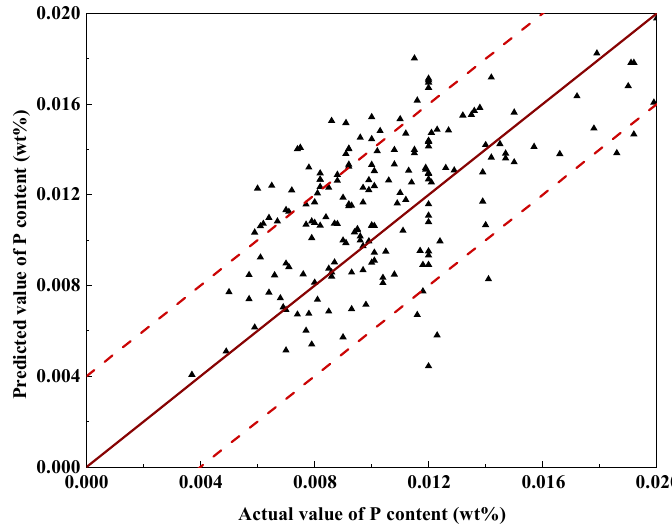
Figure 7. Results of the prediction model optimized with consumption of oxygen divided into stages.